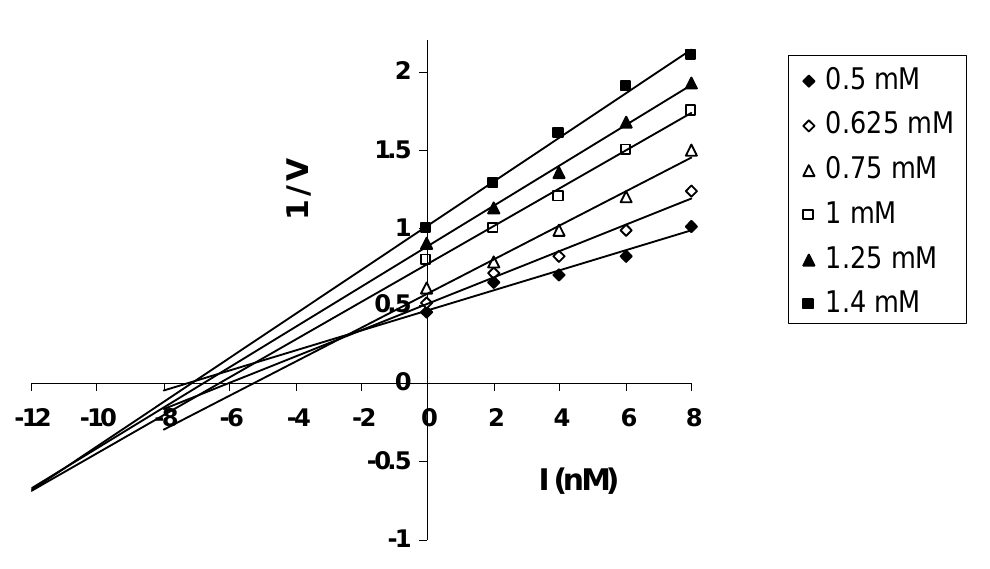
Figure 4. Dixon Plot of inverse of the rate of ATP synthesis measured in μ mol ATP (mg chlorophyll) -1 min -1 (1/V) against anion channel inhibitor DIDS concentration (I) measured in nM for ATP synthesis by spinach thylakoids. Inhibiton was studied with HCl and DIDS concentrations ranging from 0.5 mM to 1.4 mM and 0 nM to 8 nM respectively. The HCl concentrations employed were: 0.5 mM ( ♦ ); 0.625 mM ( ◊ ); 0.75 mM ( ∆ ); 1.0 mM ( □ ); 1.25 mM ( ▲ ); 1.4 mM ( ■